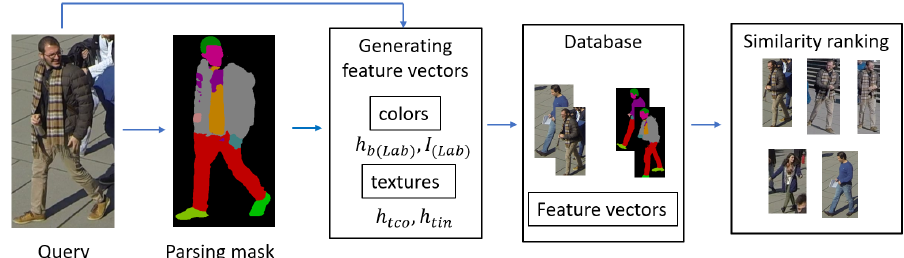
Figure 1. Method overview: parsing of the query image for the per-class feature extraction with consequent comparison with dataset images, which is conducted in order to form a similarity